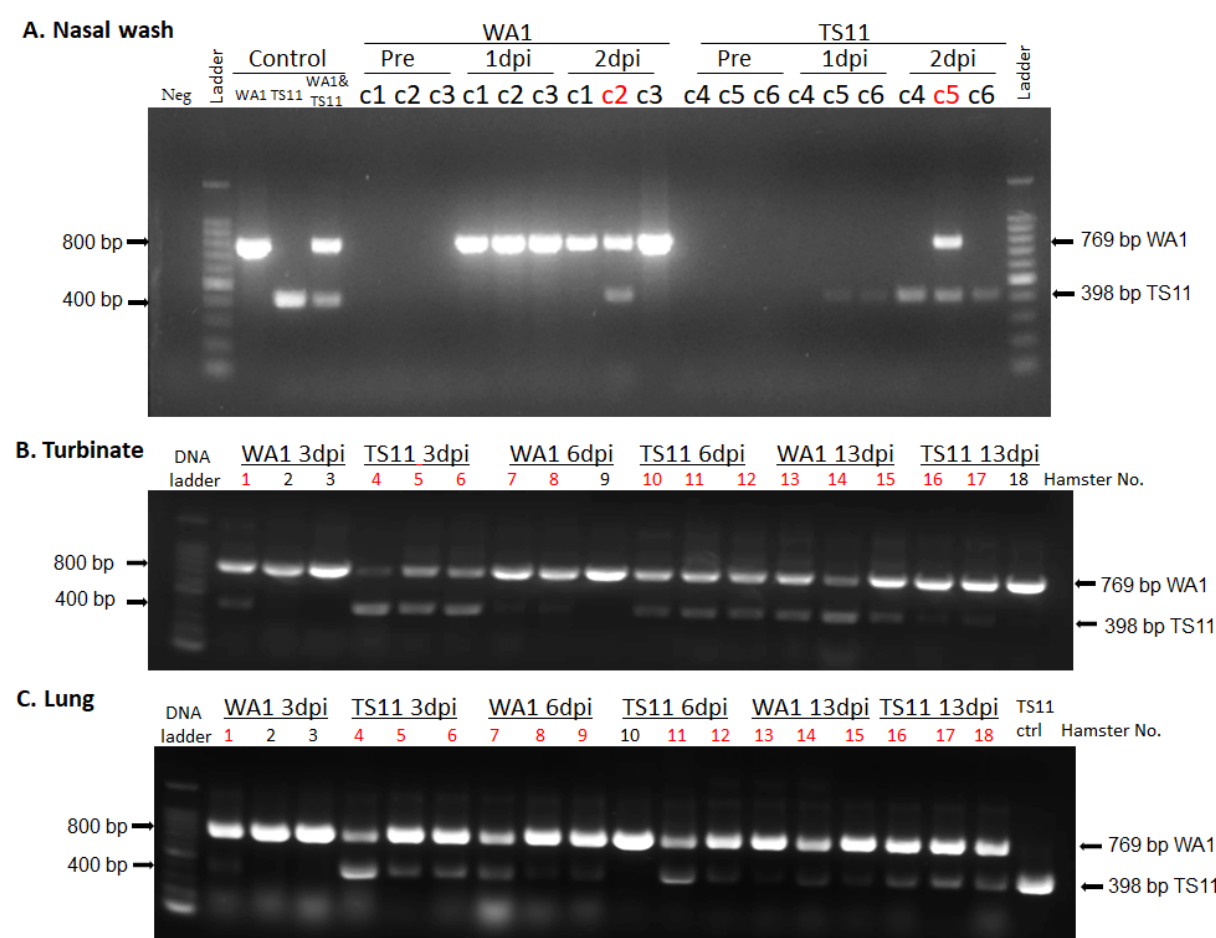
Figure 4. The detection of TS11 and WA1 viral RNA in the nasal wash ( A ), nasal turbinate ( B ) and lung ( C ) samples of hamsters using the RT-PCR that differentiates between WA1 (769 bp) and TS11 (398 bp). WA1 RNA, TS11 RNA and the 1:1 mixture of WA1 and TS11 RNA based on infectious titers (WA1&TS11) were used as positive controls; water was used as a negative (Neg) control. C1–C6 indicate randomly selected one of the three hamsters in cage #1–cage #6. The red text indicate that the sample was positive for both TS11 and WA1.